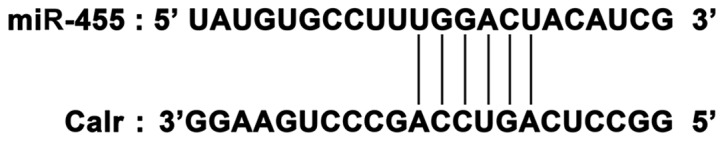
Bioinformatics analysis identified Calr as a putative target gene of miR-455. Calr, calreticulin.